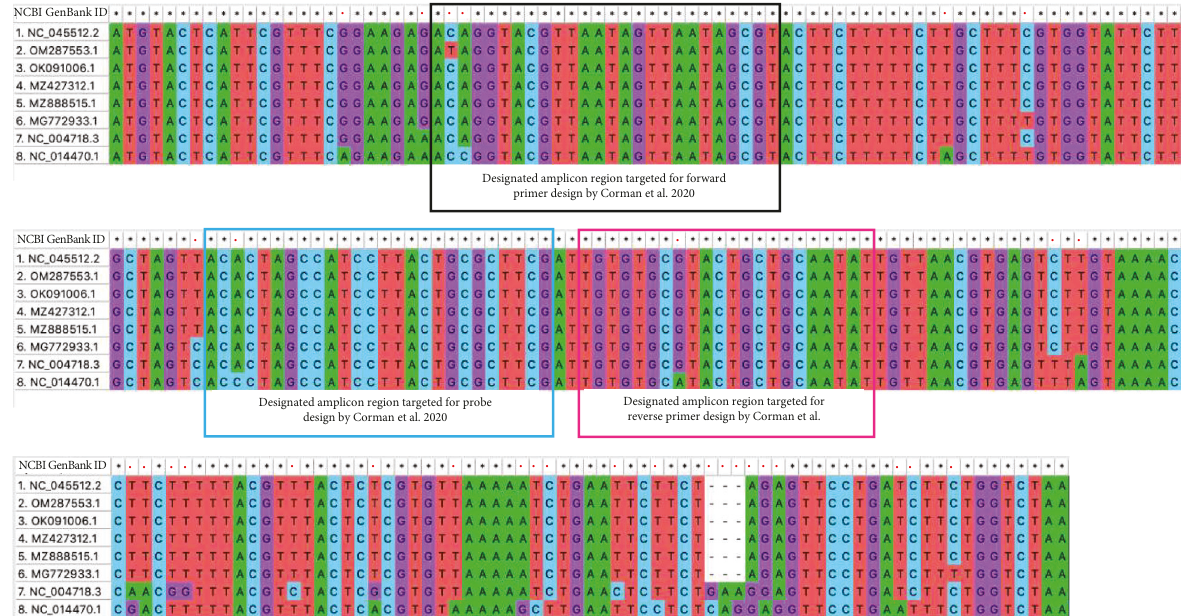
Figure 1: E gene multiple sequence alignment (MUSCLE) by MEGA11 version 0.1. The region of primers and probe was designed by [1]. Star ( ) signs denote perfect nucleotide position match, and red dots (.) denote mismatch. The black rectangle shape denotes the amplicon region for forward primer design, the blue rectangle shape denotes the amplicon region for probe design, and the pink rectangle shape denotes amplicon position for reverse primer position. Analyzed NCBI GenBank accession IDs for MSA for the entire E gene represent